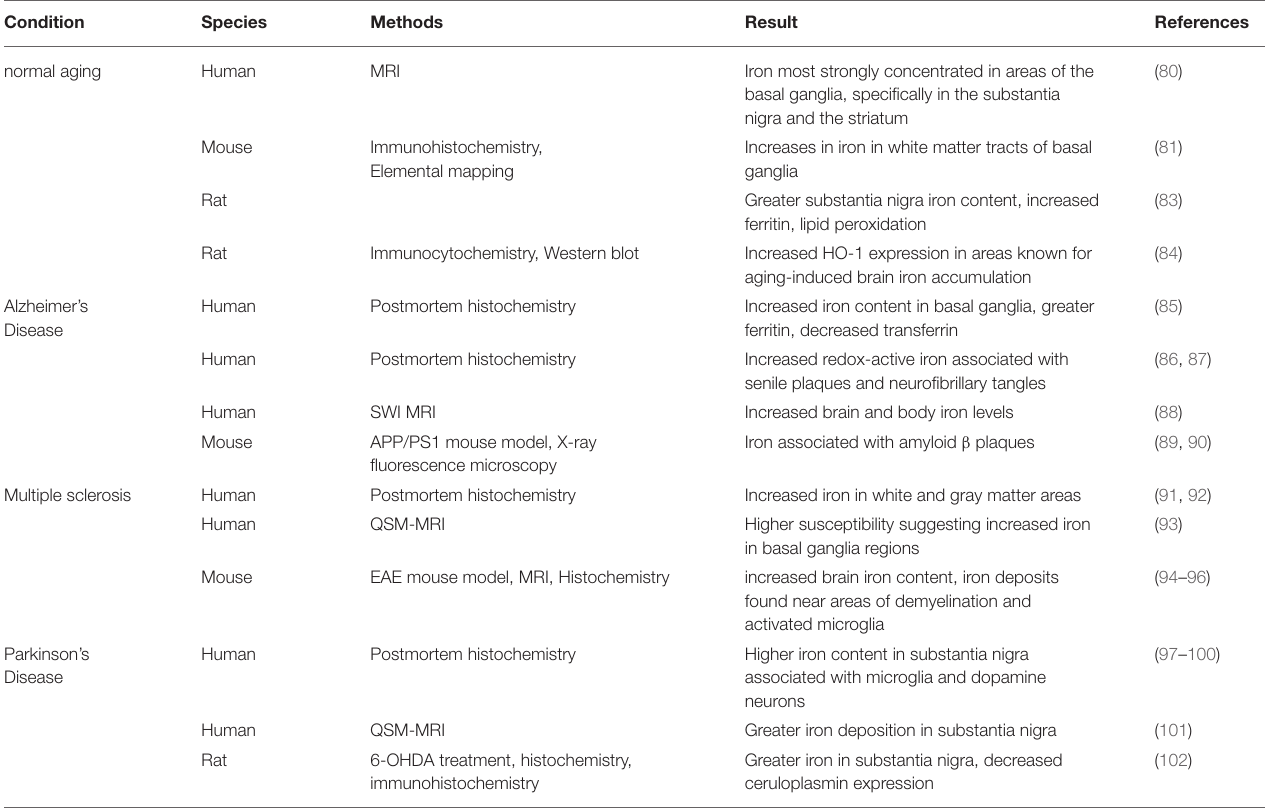
TABLE 3 | Evidence of brain iron accumulation in aging and neurodegenerative disorders.